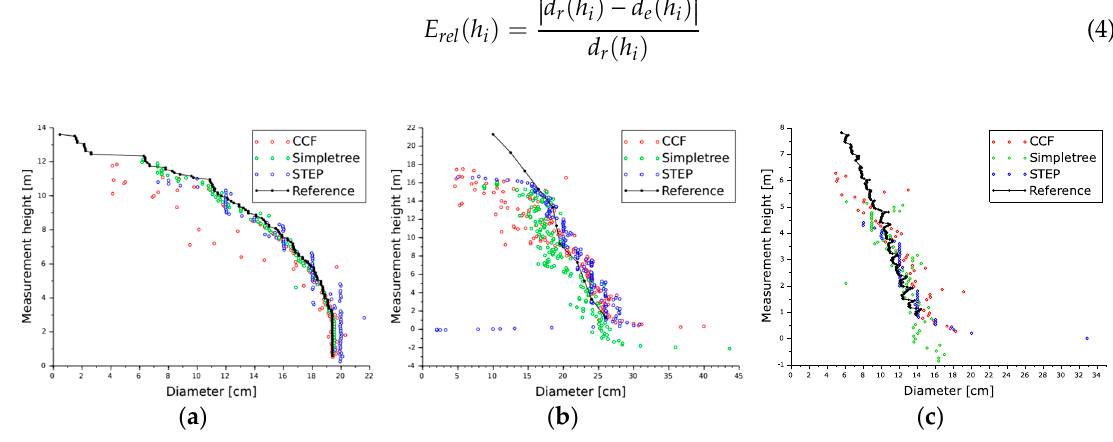
Figure 5. Example of the piecewise linear interpolation of reference measurements on three example trees from: ( a ) Newfoundland, ( b ) Phalsbourg, and ( c ) Bas Saint-Laurent test sites.